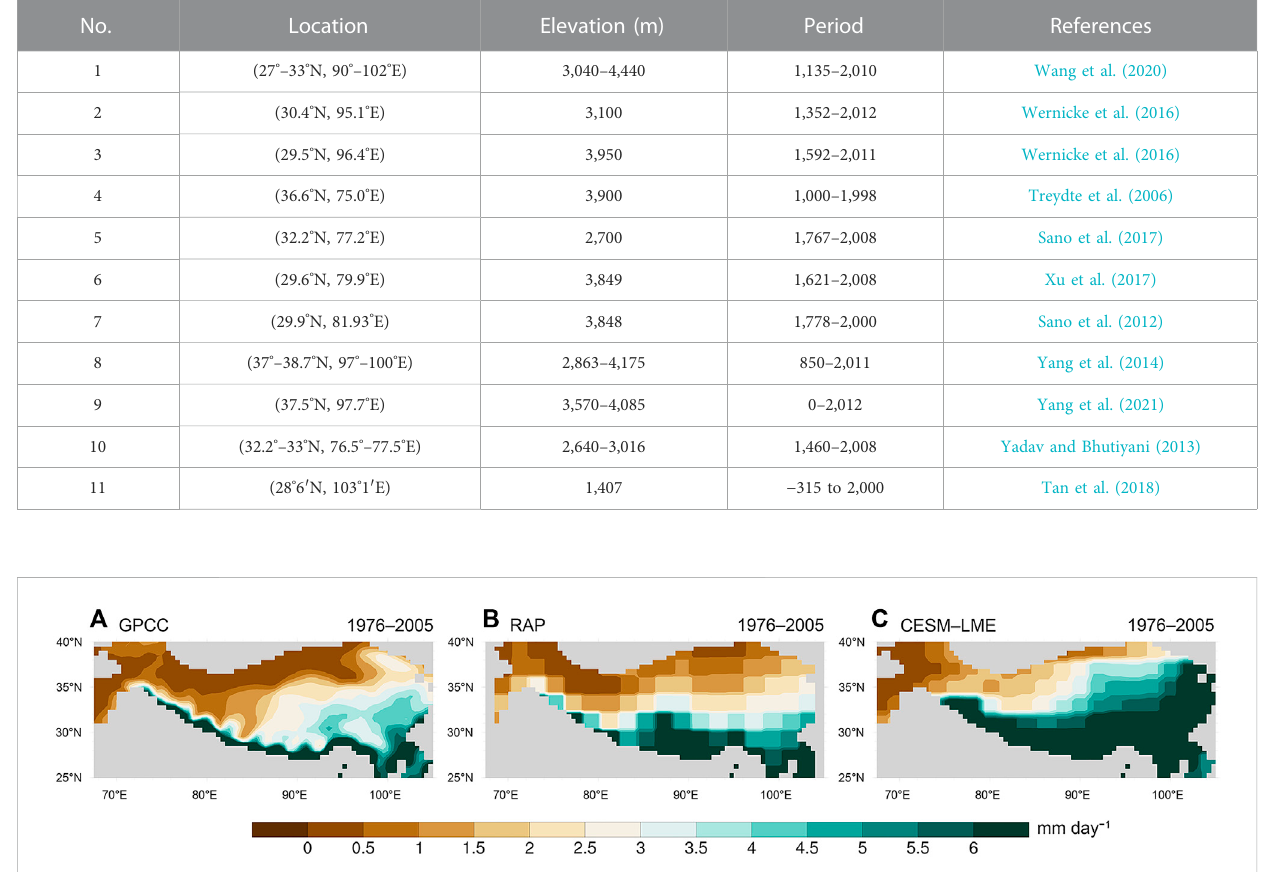
FIGURE 1 Climatological Jun – Aug (JJA) mean precipitation (mm day − 1 ) during the period 1976 – 2005 derived from (A) GPCC, (B) RAP, and (C) CESM ‒